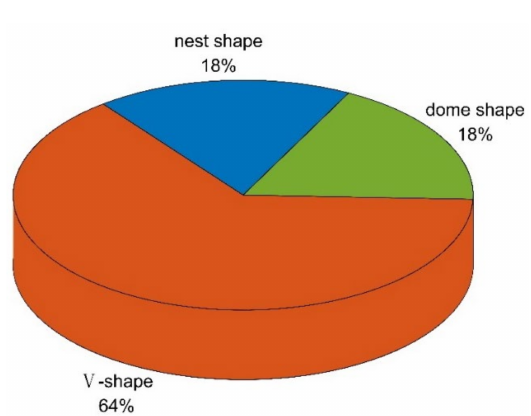
Figure 4. The proportion of different blasting pit shapes.